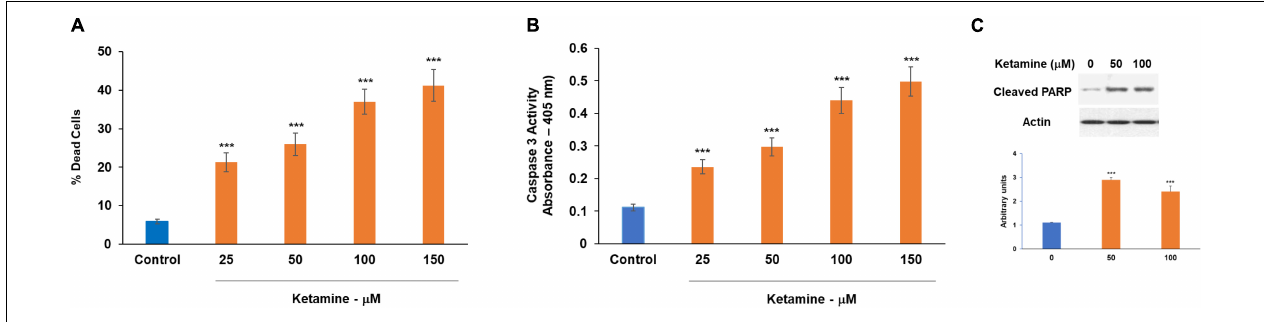
FIGURE 1 | Neurotoxic effects of ketamine on human neuronal cells. Human neurons were treated with ketamine for 6 h. The medium was replaced with fresh medium and% dead cells was determined following 48 h using the live/dead assay (A) , caspase 3 activity (B) and analysis of cleaved PARP by Western blot analysis (C) . The results are the means ± SD of three different experiments analyzed in quadruplet (A,B) or a representative of three independent experiments (C) *** P < 0.001.